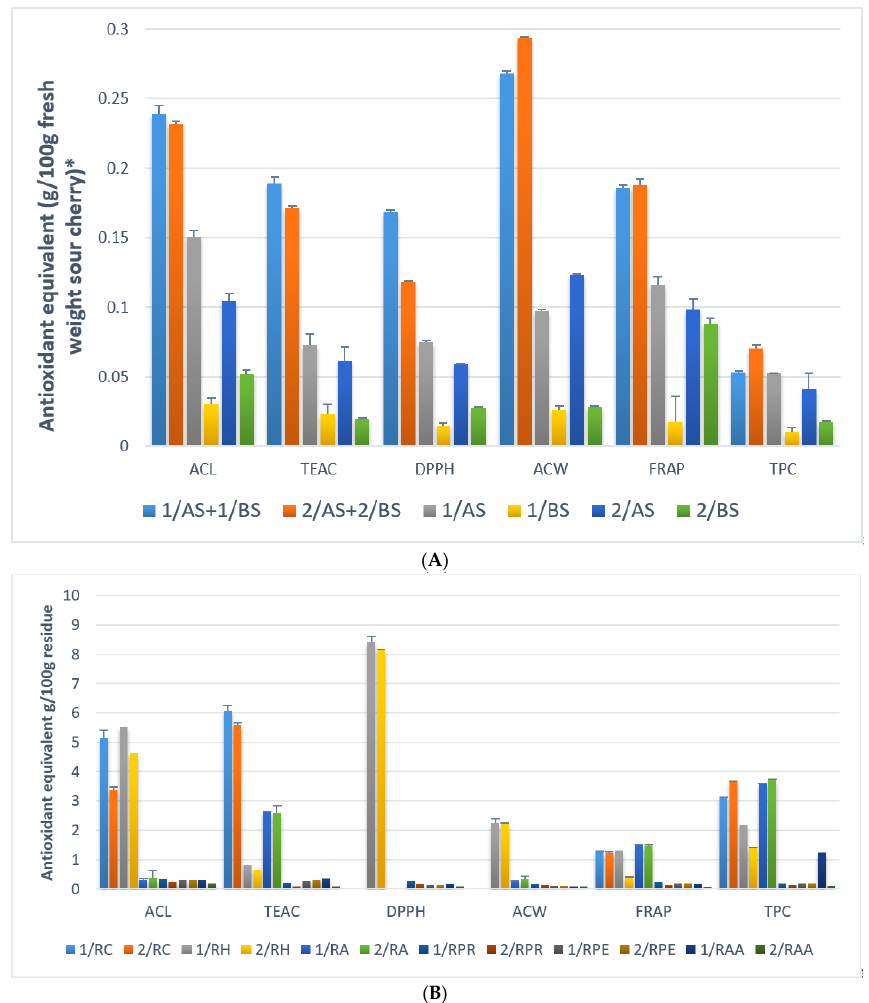
Figure 5. ESI-MS2 spectrum of procyanidin B. ( A ) Comparison of the extractable antioxidant capacity of sour cherry-extracts and the totalphenolic content. * Units for different measurement methods: ACL: Trolox equivalent g/100g; TEAC: Trolox equivalent g/100g; DPPH: Trolox equivalent g/100g; ACW: Ascorbic acid g/100 g; FRAP: Ascorbic acid g/100 g; TPC: Gallic acid g/100g. Abbreviations: 1/AS: evaporated ethanol:water extract; 1/BS: evaporated ethanol extract after ethanol:water extraction; 1/AS + 1/BS: 1/AS and 1/BS extracts evaporated together; 2/AS: evaporated acidic methanol:water extract; 2/BS: evaporated acetone:water extract after methanol:water extraction; 2/AS + 2/BS: 2/AS and 2/BS extracts evaporated